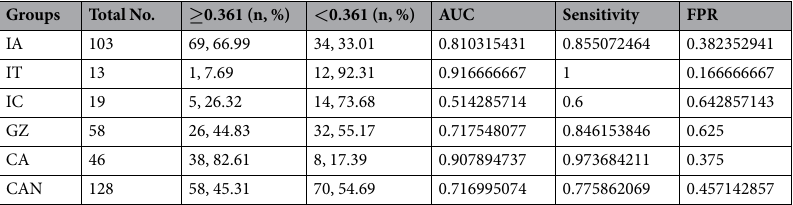
Table 3. Evaluation of NK Immunity Based on Baseline Clinical Parameters According to NK Score in CHB Patients with Different